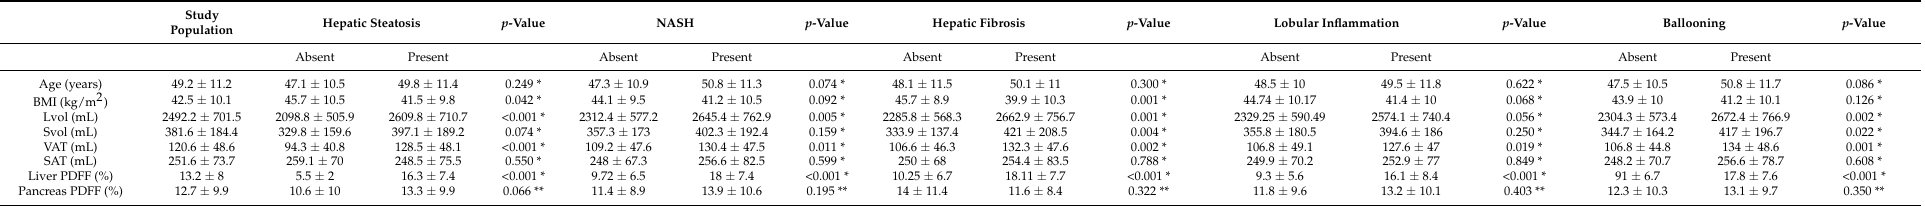
Table 2. Table showing differences in age, BMI, Lvol, Svol, VAT, SAT, liver PDFF and pancreas PDFF according to the presence of HS, NASH, HF, lobular inflammation and ballooning in the study cohort